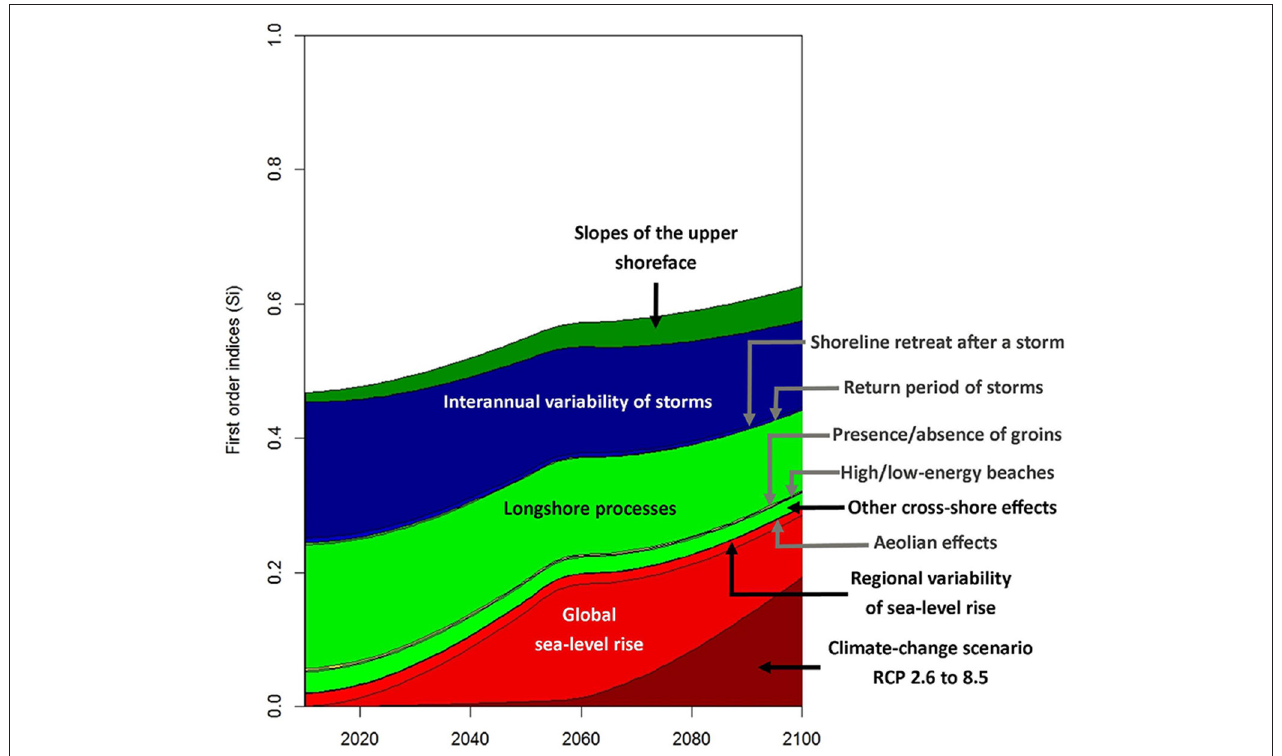
FIGURE 7 | Evolution of the first order Sobol’ indices over the time, indicating the contribution of each varying parameter alone to the final uncertainty. Parameters indicated in gray have the smallest 1st order Sobol’ indices. The inflexion of the curves after 2060 is due to two phenomena: first, the different climate change scenarios (RCP 2.6–8.5) induce different sea-level rise projections by that time (see Figure 1 ); second, shoreline change projections uncertainties by 2100 is much larger by 2100 than now (see text). The colors (red, green, blue, and yellow) indicate uncertainties related to (1) climate change and sea-level rise, (2) local site characteristics, (3) impacts of storms, and (4) of coastal defenses (groins).